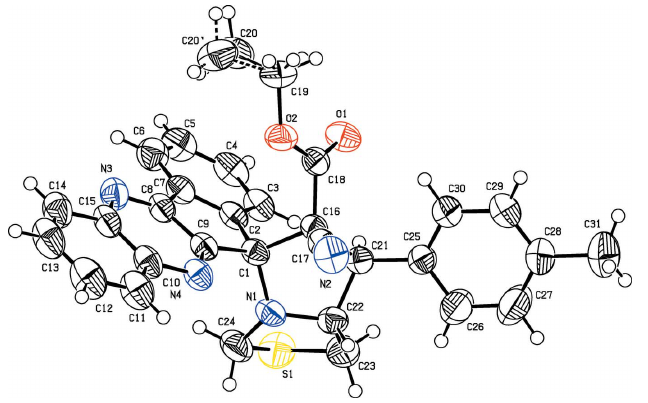
Figure 3 C (11) chain motif extending along the ab -axis of the unit cell formed by a C—H (cid:3)(cid:3)(cid:3) S interaction. Hydrogen bonds are shown as dashed lines. The minor component of the disordered –CH 3 group (C20 atom) is omitted for clarity.